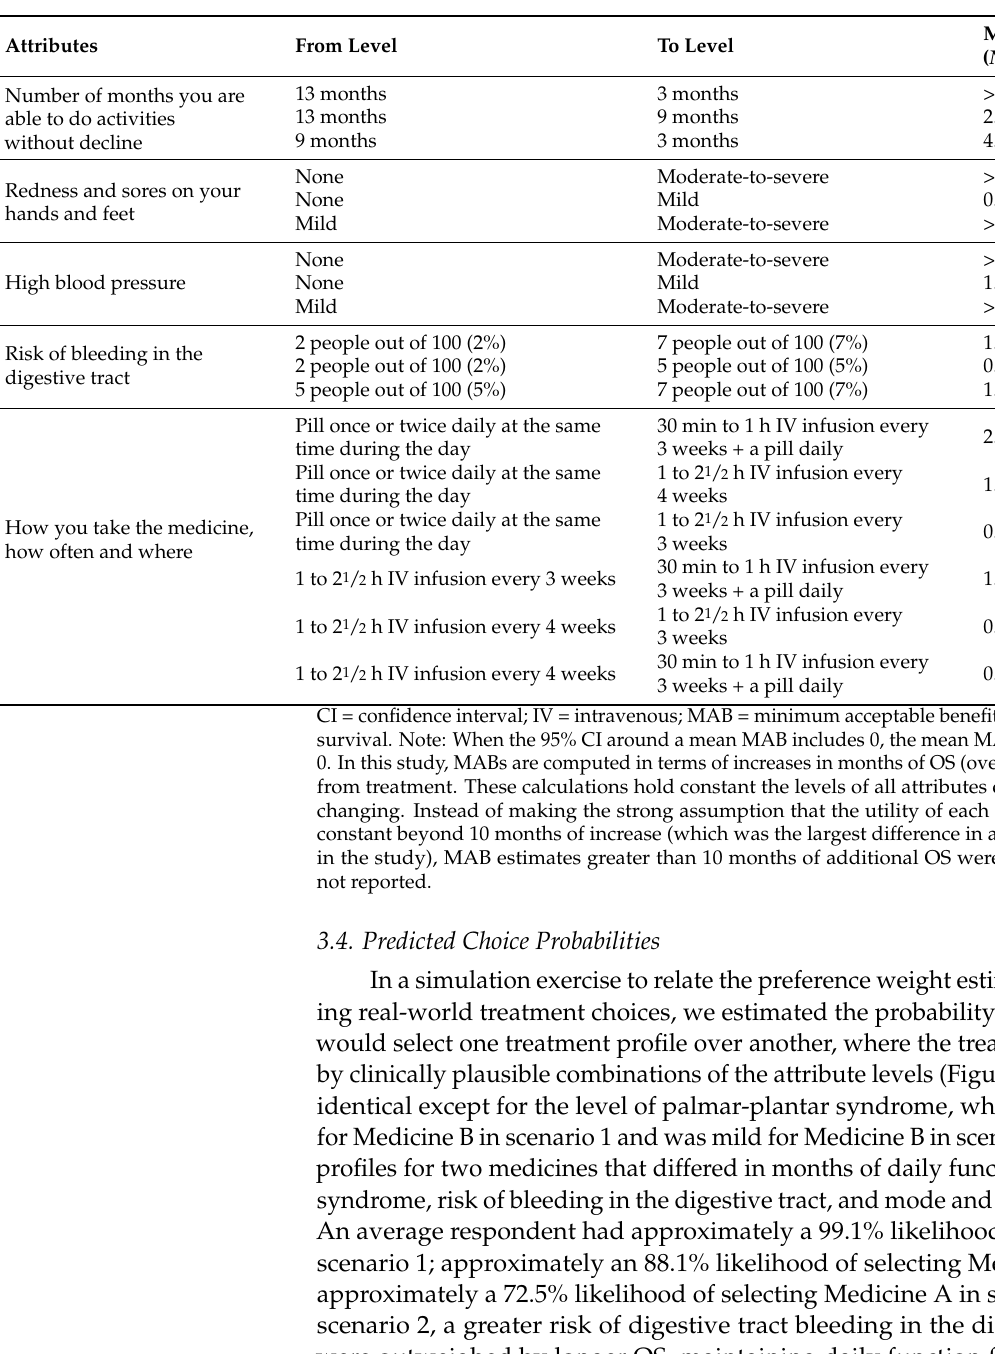
Table 3. Minimum acceptable benefit as an increase in additional months of overall survival for a given change in treatment